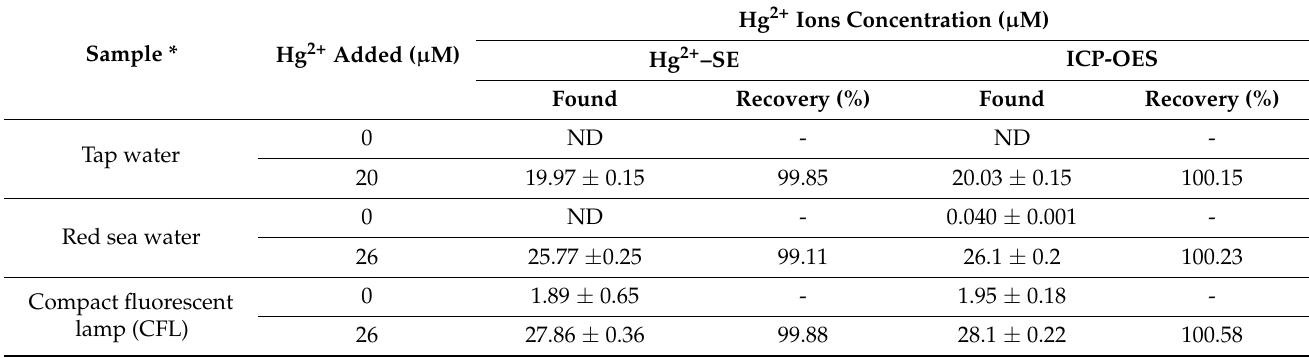
Table 4. The analysis of mercury in some real samples.